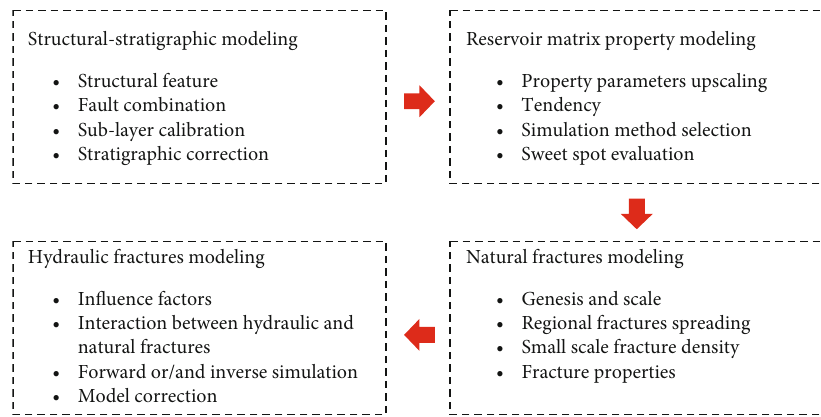
Figure 18: The main contents of each type of model should be included and the relationship among them in shale gas geological modeling.